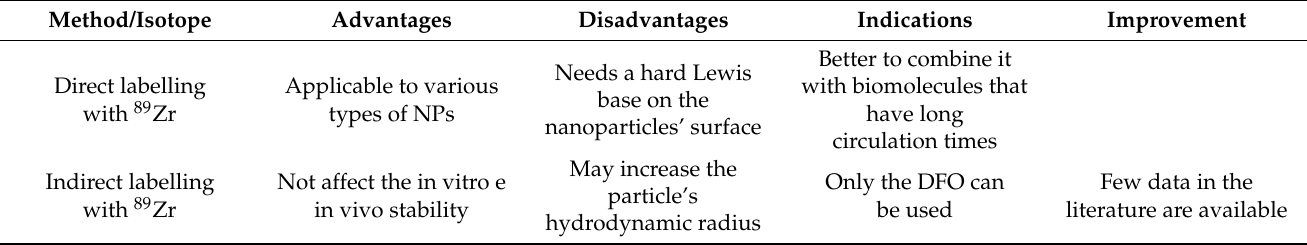
Table 3. Pros and cons of different methods for radiolabelling NPs with